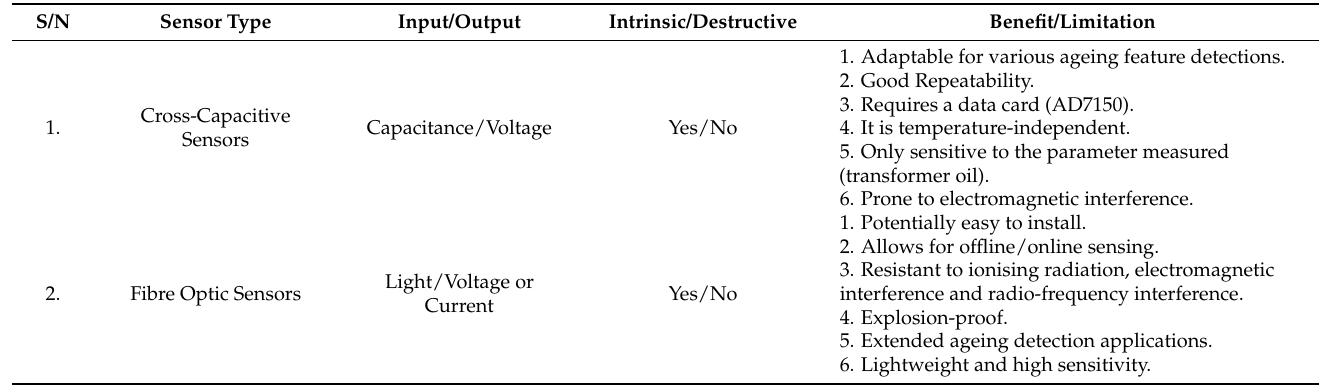
Table 5. Cross Capacitive Sensor and Fibre Optic Sensor